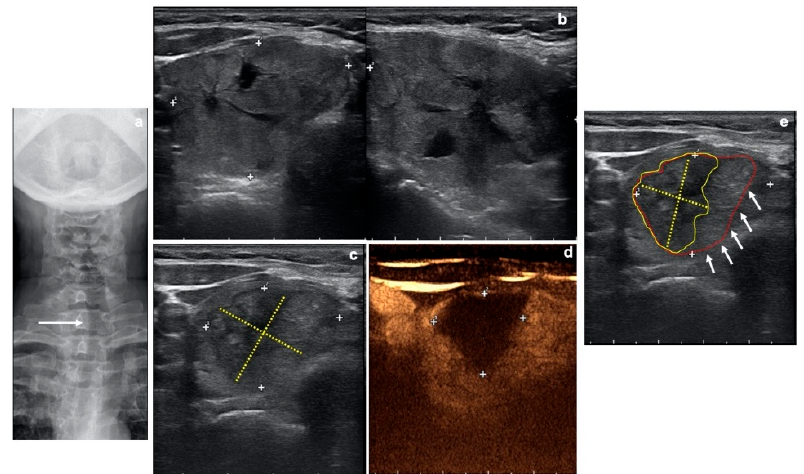
Figure 2. Case of a 56-year-old woman treated with radiofrequency ablation. ( a ) Thoracic inlet X-ray showing a large retrosternal goiter with left deviation (white arrow) and indentation of the trachea. ( b ) Two-planes gray-scale ultrasound (US) showing pretreatment evaluation of an almost completely solid right thyroid lobe nodule (Volume: 28.8 mL). ( c ) Gray-scale US at 6 months after treatment showing volumetric reduction of the ablated nodule (yellow dotted lines = evaluation of the ablated area with B-mode US). ( d ) Contrast-enhanced ultrasound (CEUS) at 6 months after treatment demonstrating the area of ablation as an area with lack of enhancement (white crosses = evaluation of the ablated area with CEUS). ( e ) After CEUS-treated nodule evaluation, treatment results can be better reconsidered on the grey-scale US (c) showing real ablated nodule margins (yellow dotted lines and encircled area) as compared to previously measured margins (white arrows; red encircled area) .